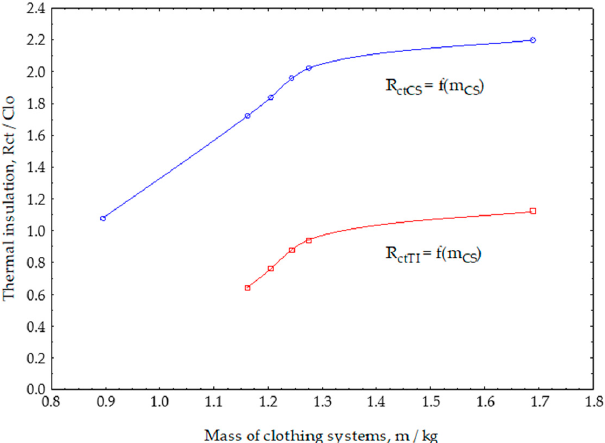
Figure 6. Functional dependence on the value of thermal insulations of clothing systems on the mass of the integrated textile material with thermal insulation of the integrated textile material with thermal insulation properties.